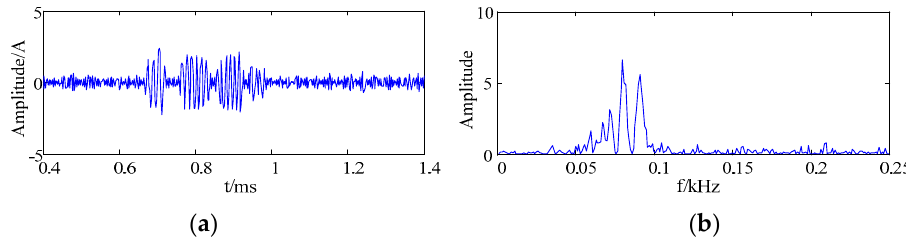
Figure 6. The waveform and spectrum after denoising by EMD ( a ) the waveform; ( b ) the frequency spectrum.